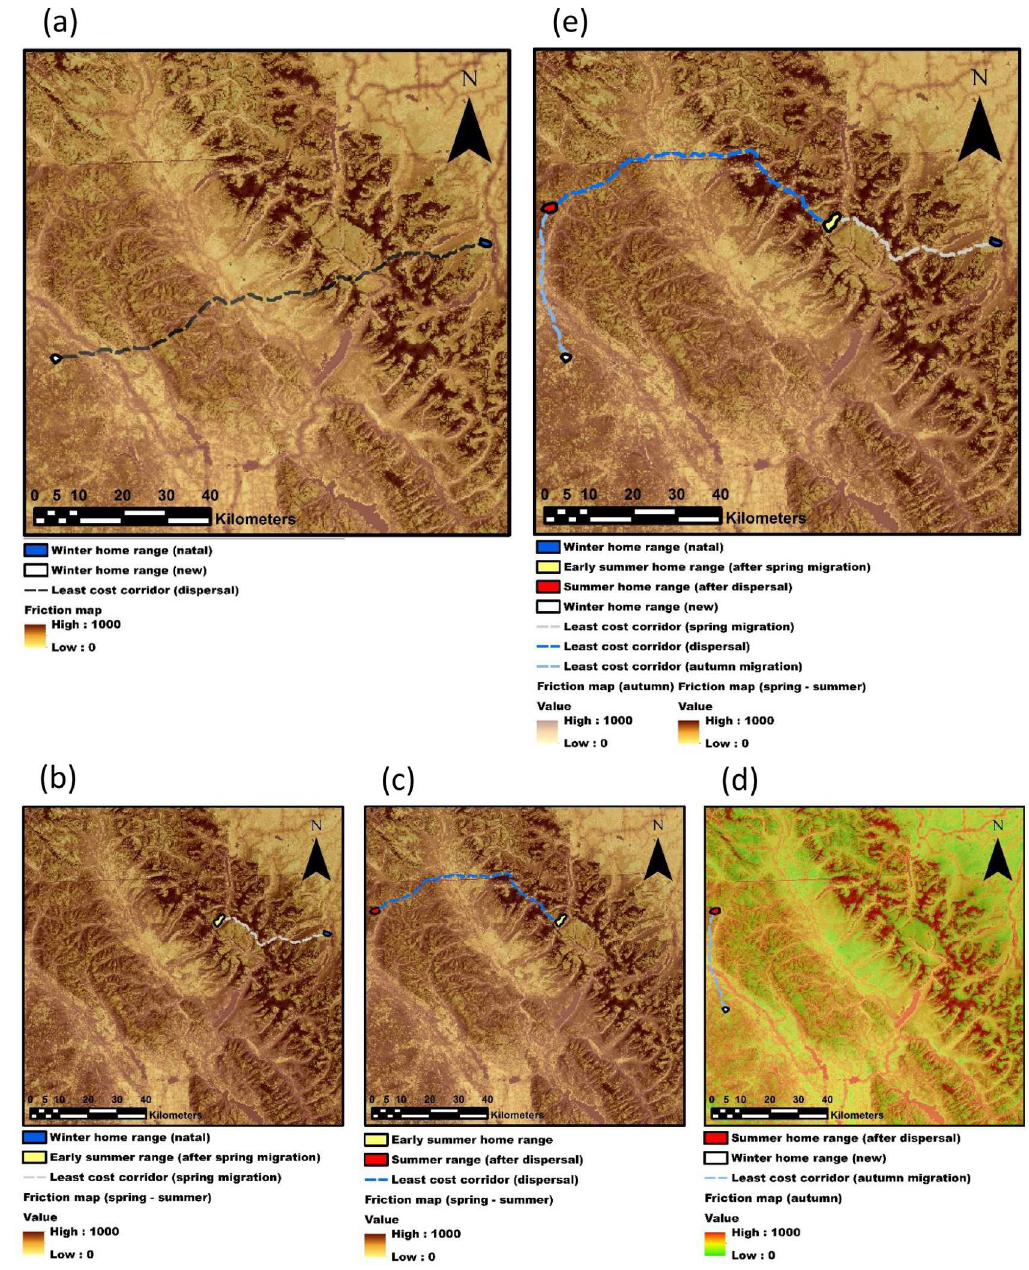
Fig 1. Conceptual figure illustrating the rationale behind the approach described in this study. The example refers to the identificationof a wildlife corridor connecting two core areas, i . e ., a hypothetical elk winter range and a new one reached after a dispersalevent. Typical connectivity models (a) would depict the least cost corridor connecting the two areas, which is the most likely path given a friction map on the background. Our approach highlightsthe importanceto implement behaviouralecology (in this case, dispersalecology) into connectivity modellingscience. A young male elk usually migrates during late spring—early summer with the mother’s group, moving from the natal winter range to the early summer range (b). During summer, the young elk may disperse to a new suitable summer home range (c), and, in autumn, eventuallymove to the new winter range (d). If the animal will adopt the migratory strategy, then it will periodicallymigrate between the new winter range and the new summer range (d). Implementing dispersalecology into connectivity modellingmeans combininga sequenceof migratory and dispersalmovements (e, resulting from b + c + d), which suggests a very different potential wildlife corridor (e) compared to the one predicted by simply connecting the two winter ranges (a).